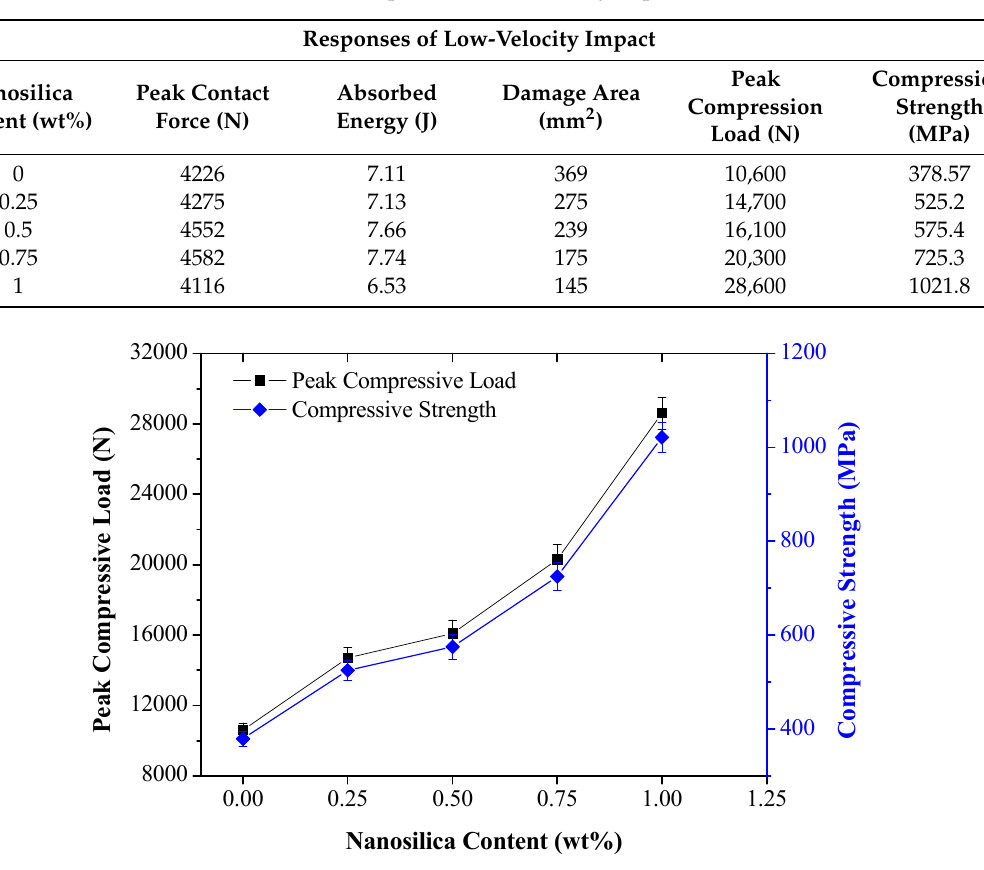
Figure 6. Post-impact compressive behavior of pristine and toughened composites.